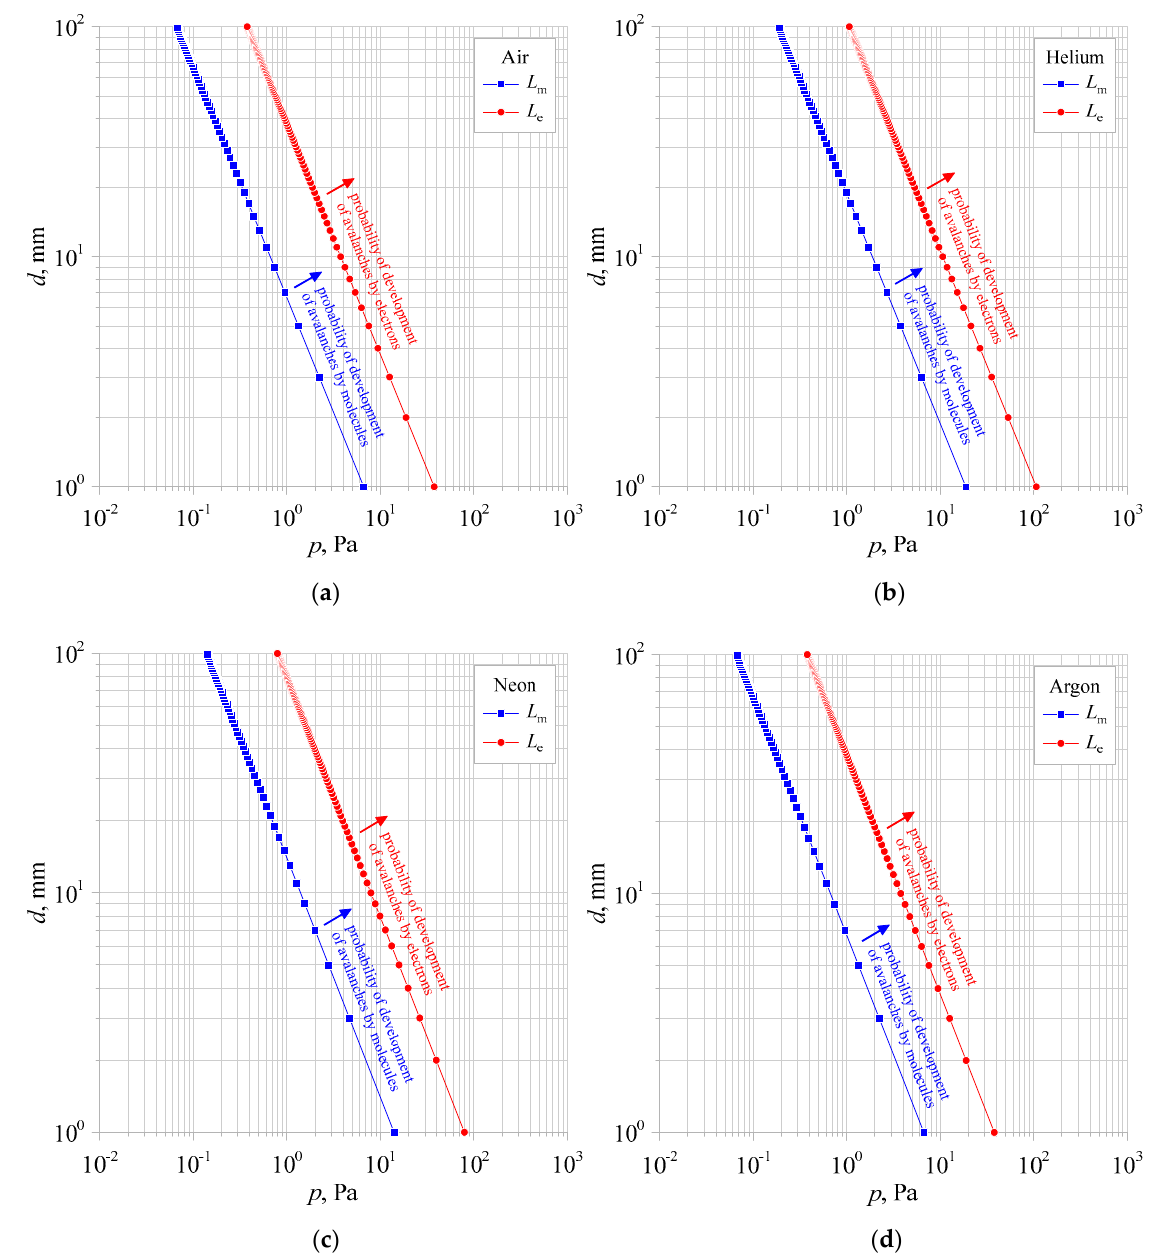
Figure 2. Characteristics to determine the value of pressure p at which the mean free paths of molecules L m and electrons L e are equal to the contact gap d in the environment of selected gases: ( a ) air, ( b ) helium, ( c ) neon, ( d ) argon.